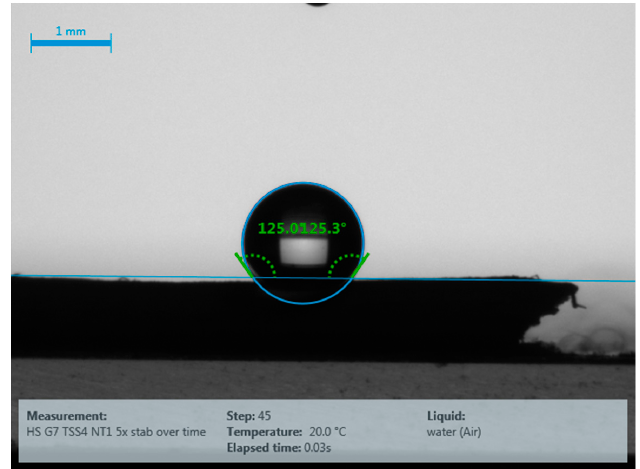
Figure 1. DSA image captured via the Krüss Advance software, with the example of sample H4-1-5. Courtesy of TWI Ltd.